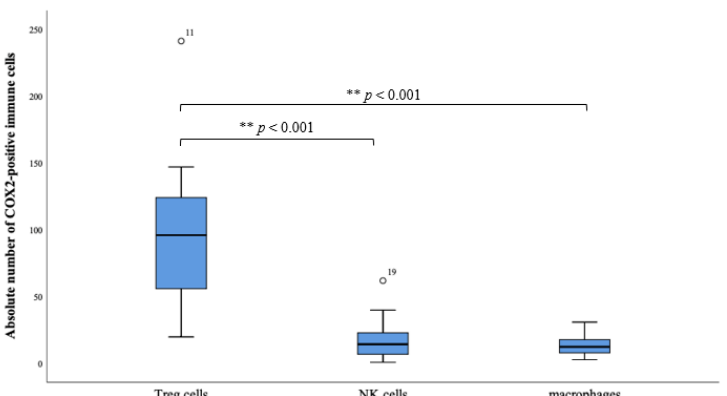
Figure 3. The boxplots reveal the absolute number of COX-2 positive Treg cells (FOXP3+), NK cells (CD56+) and macrophages (CD68+). There is a clear distribution in the direction of the Treg cells. The box plots indicate mild outliers, which are marked with circles. These outliers (case numbers 11 and 19) show an interquartile distance to the third quartile of values that is less than three times higher than the third quartile of values. The difference of the occurrence of the subtypes Treg cells to NK cells, as well as Treg cells to macrophages, is highly significant (** p < 0.001). 2.3. M2-Polarized Macrophages Are Mainly Located on and in Tumor Tissue In a further step, the CD68-positive macrophages were differentiated into M2-polar- ized and non-M2-polarized macrophages using PPAR γ as specific marker. In fact, it was already reported that PPAR γ plays an essential role as a nuclear receptor for the matura- tion of alternatively activated M2 macrophages [41] and also primes monocytes into M2 macrophages [42]. M2-polarized macrophages were found to be located peri- to intratumorally and those without M2-polarization remained in the stroma. (Figure 4A,C). Figure 4. The picture series ( A – C ) demonstrate the double staining with PPAR 𝛾 (red) and CD68 (green). This allows a subtyping of CD68-positive macrophages into M2-polarized and M2-unpo- larized macrophages. PPAR 𝛾 acts as a marker for the M2-polarization of the macrophages. In the